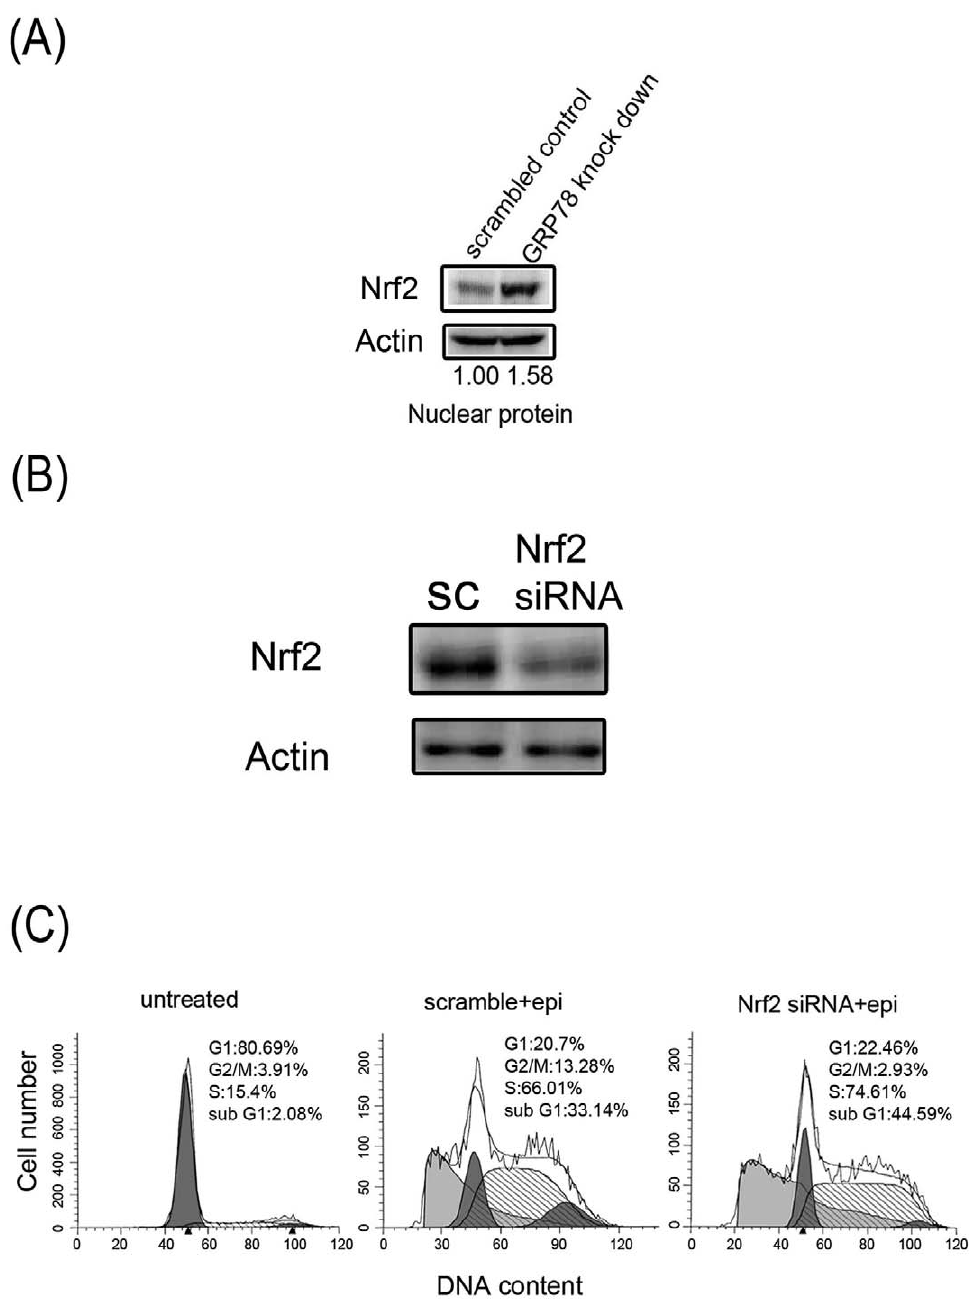
Figure 3. The effect of Nrf2 on epirubicin (epi) treatment. (A) Scrambled control and GRP78 knockdown DLD-1 cells were cultured for 48 h, and nuclear Nrf2 expression was evaluated by western blotting. (B) The GRP78 knockdown DLD-1 cells were pretreated with scrambled siRNA (sc) or Nrf2 siRNA for 24 h, and nuclear Nrf2 expression was evaluated by western blotting. (C) The GRP78 knockdown DLD-1 cells were pretreated with scrambled siRNA (scramble) or Nrf2 siRNA for 24 h and treated with 500 ng/ml epirubicin (epi) for another 48 h. After treatment, the percentage of cells that were in the subG 1 phase indicated by DNA damage was determined as outlined in the Materials and Methods . These experiments were performed at least 3 times, and a representative experiment is